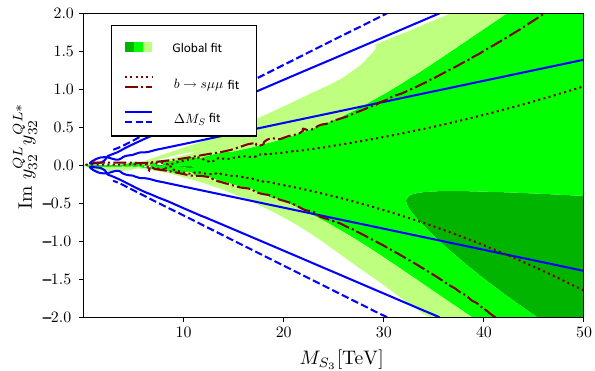
Fig. 5 Fit on S 3 leptoquark parameter space in the M S plane (see text) ∗ y QL y QL imposed by b → s μ + μ − decays and B s -mixing 32 22 are presented in Fig. 5. The observables used in the respec- tive fits are the same as in Fig. 3. The red lines (dotted, dash-dotted) correspond to the fit using only semi-leptonic B -meson decays, i.e. b → s μ + μ − plus the branching ratios BR ( B s → μ + μ − ) and BR ( B 0 → μ + μ − ) , the best fit region is the one between the curves; dotted lines: Δχ 2 = 1, dash- dotted lines: Δχ 2 = 4. Blue lines (solid, dashed) corre- spond to the fit to B s -mixing observables Δ M s and A mix The best fit region is the one between the lines; solid lines Δχ 2 = 1, dashed lines Δχ 2 = 4, there are two regions with Δχ 2 < 1, but between them Δχ 2 is always smaller than 4. The green regions are the combined global fit: dark region Δχ 2 ≤ 1, medium Δχ 2 ≤ 4 and light Δχ 2 ≤ 9.